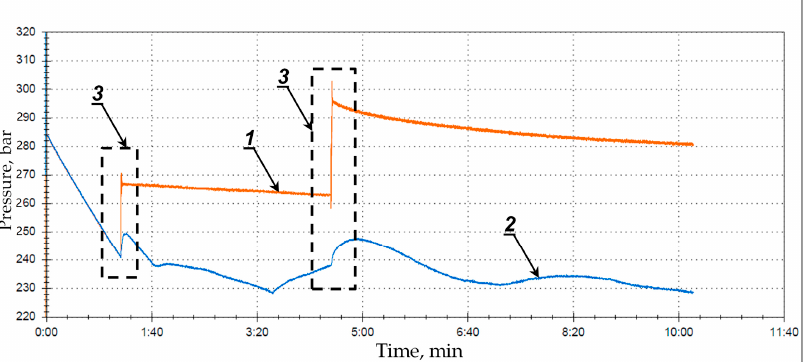
Figure 12. Testing of the prop along with the double block with pressure boost, where 1—prop expansion phase, 2—area of the loss of load capacity, 3—automatic start of recharging, 4—boost pressure in the block, and 5—pressure in the sub-piston space of the prop. Figures 13 and 14 show the obtained measurements for the charging function. These graphs show the actual measurements for the boost function up to 50 bar, decreasing due to internal leaks.